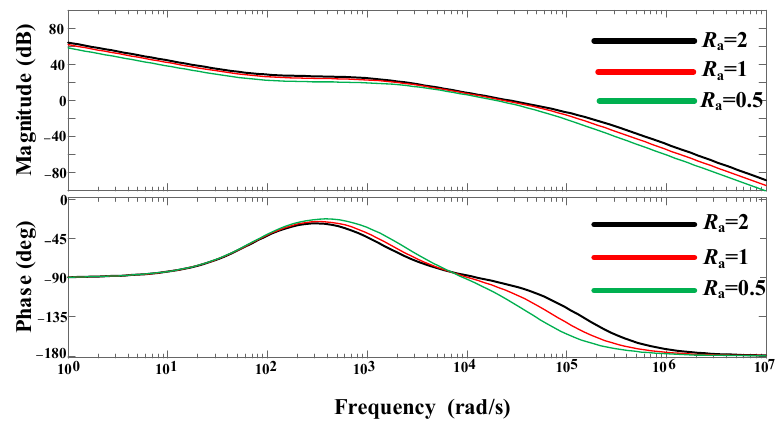
－ 3 × Figure 8. Step response of 𝐺 (cid:2931) under different 𝑅 (cid:2911) . We change Equation (11) into Equation (15), K is the open-loop gain of 𝐺 (cid:2931) . pi (15) The open-loop gain K of 𝐺 (cid:2931) can be expressed as: